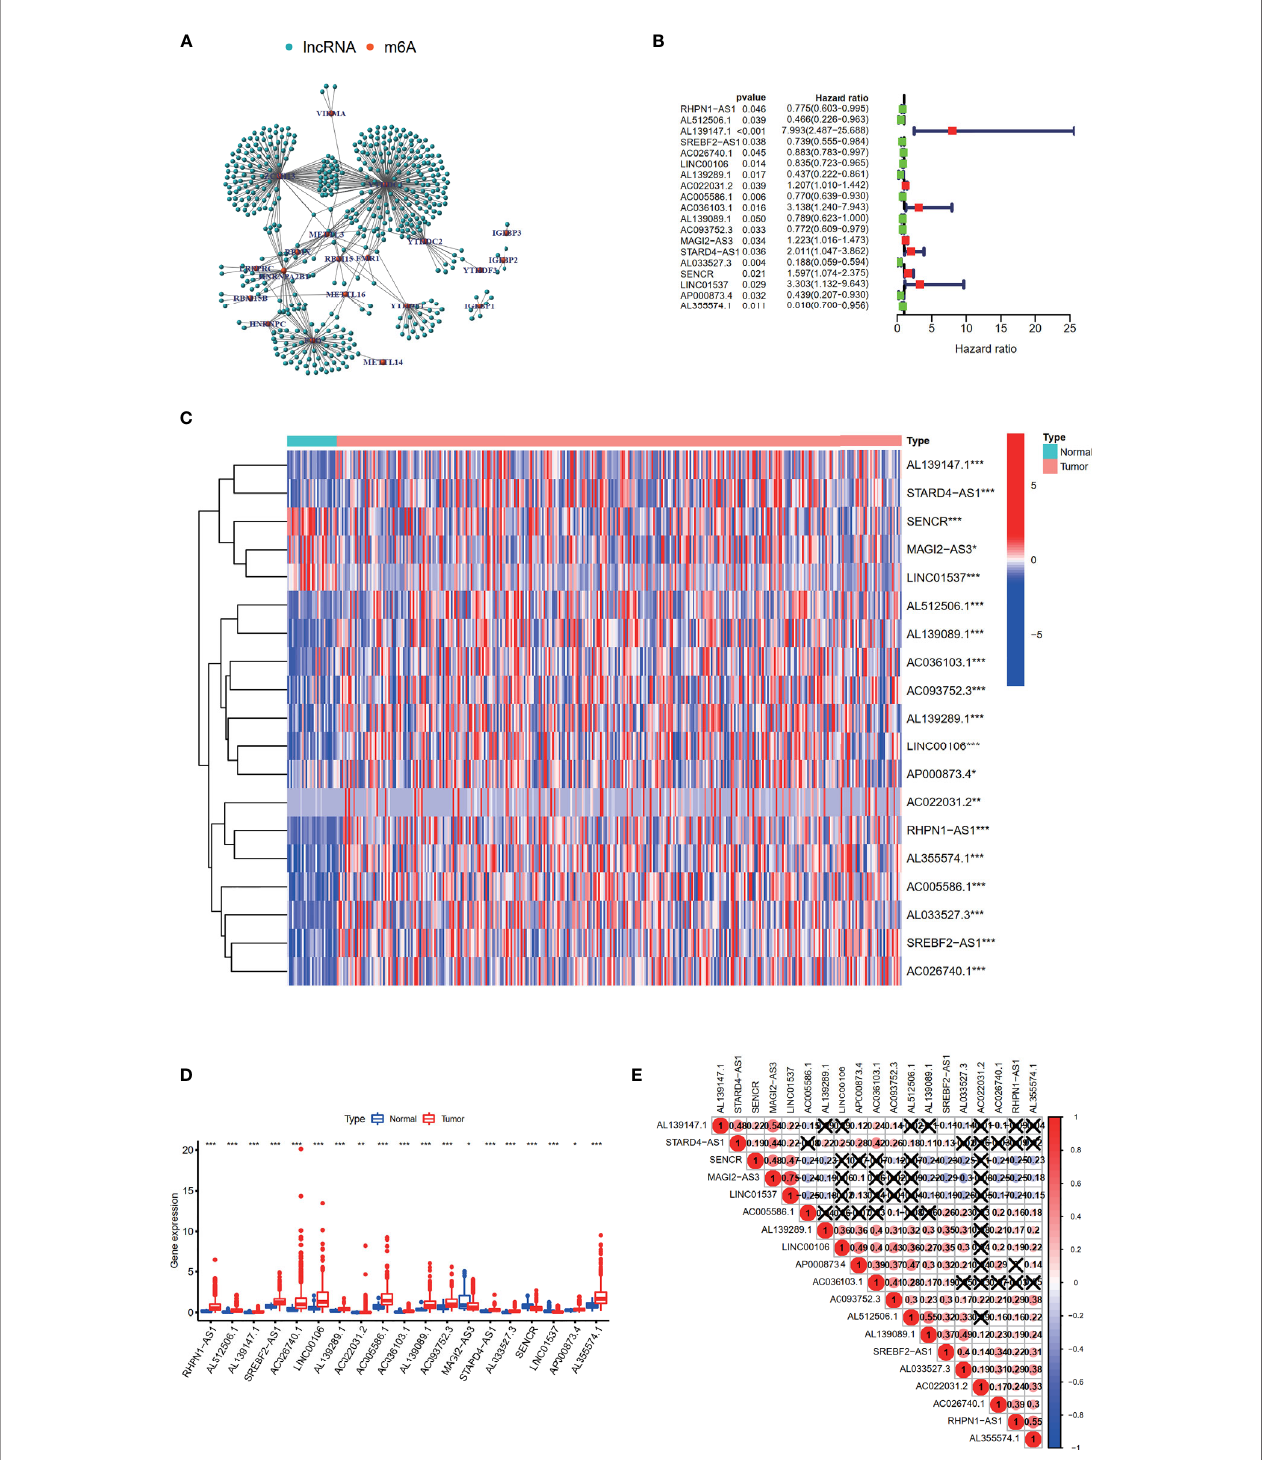
FIGURE 2 | Identi fi cation of m 6 A-related prognostic lncRNAs in STAD patients. (A) The network of the 24 m 6 A-related regulators and 471 m 6 A-related lncRNAs. (B) The hazard ratio (HR) and 95% con fi dence interval (CI) of 19 m 6 A-related lncRNAs estimated by univariate Cox regression. (C, D) The expression of 19 prognostic m 6 A-related lncRNAs in TCGA database between the tumor group and the normal group. (E) Spearman ’ s correlation analysis of the 19 m 6 A-related prognostic lncRNAs. * p < 0.05, ** p < 0.01, and *** p <